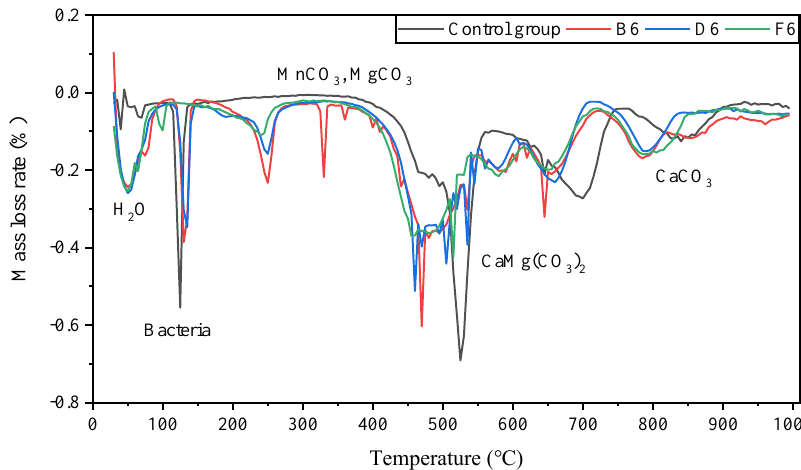
Figure 10. DTG results of classic samples.